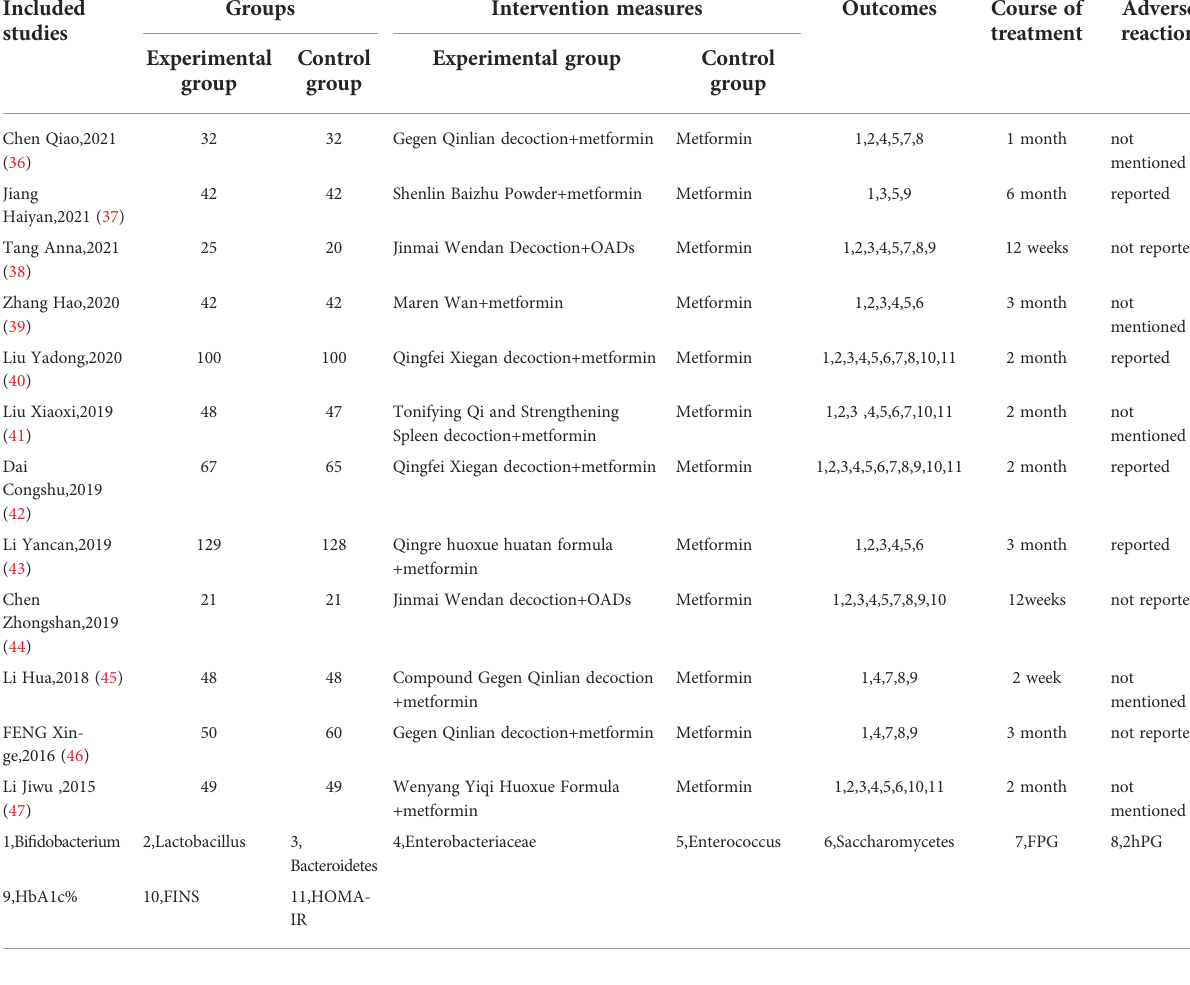
TABLE 1 Detailed characteristics of the eligible studies.